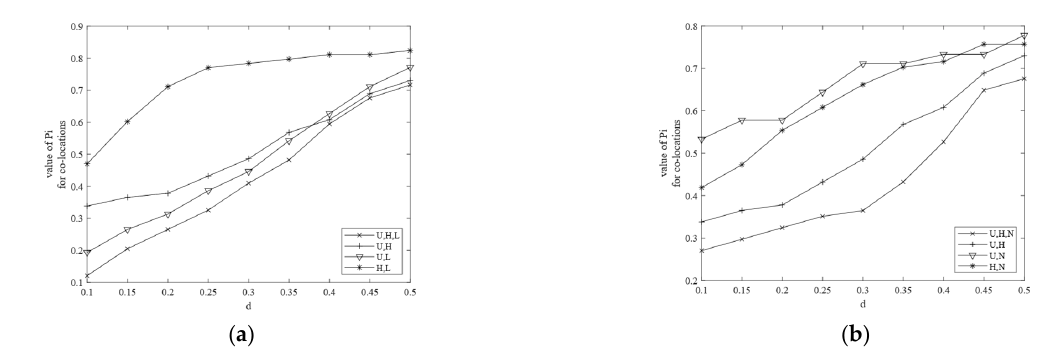
Figure 10. ( a ) Pi of { U , H , L } , { U , H } , { U , L } and { H , L } ; ( b ) Pi of { U , H , N } , { U , H } , { U , N } and { H , N } .